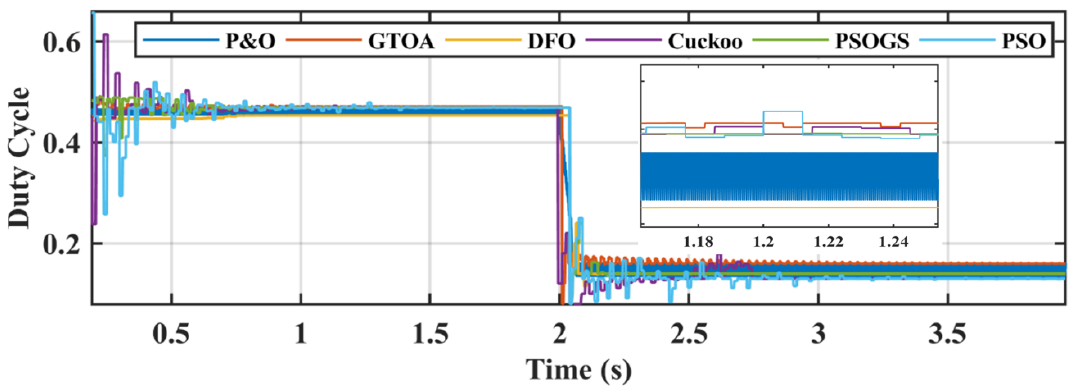
Figure 11. Comparison of duty cycle of GTOA.